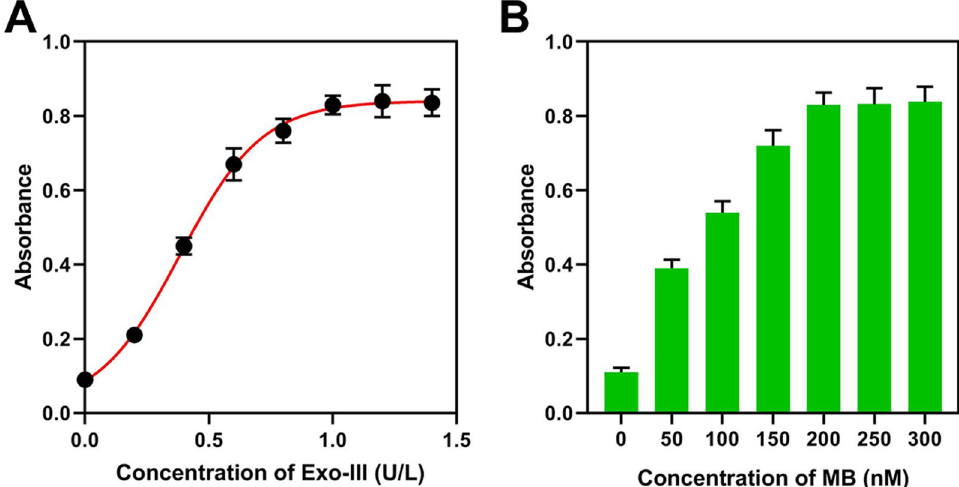
Fig. 4 Optimization of experimental parameters. A Absorbance of the approach when the sensing system is incubated with different concentrations of Exo-III. B Absorbance of the approach with different concentrations of